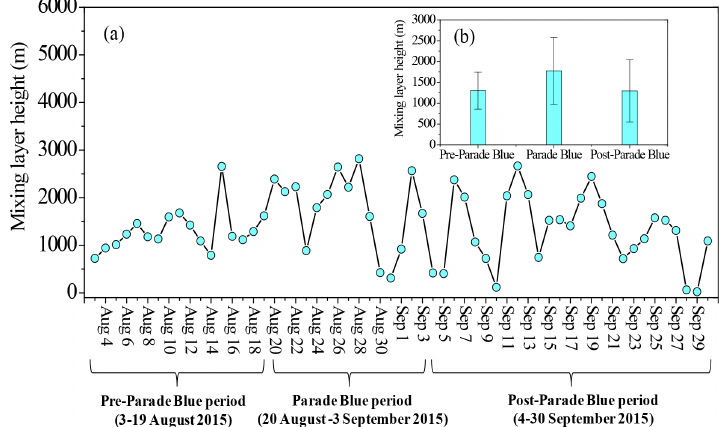
Figure 9. Dynamics of daily mean atmospheric mixing layer height (MLH) in Beijing from 3 August to 30 September 2015 (a) and compar- ison of MLH means during the pre-Parade Blue, Parade Blue and post-Parade Blue periods (b) .